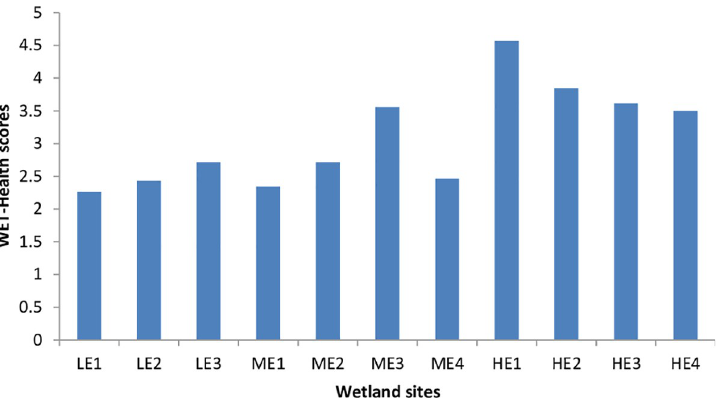
Fig 2. The WET-Health scores recorded in each of the selected wetland sites (LE 1–3 = Less Eroded, ME1- 4 = Moderately Eroded, HE1-4 = Highly Eroded).